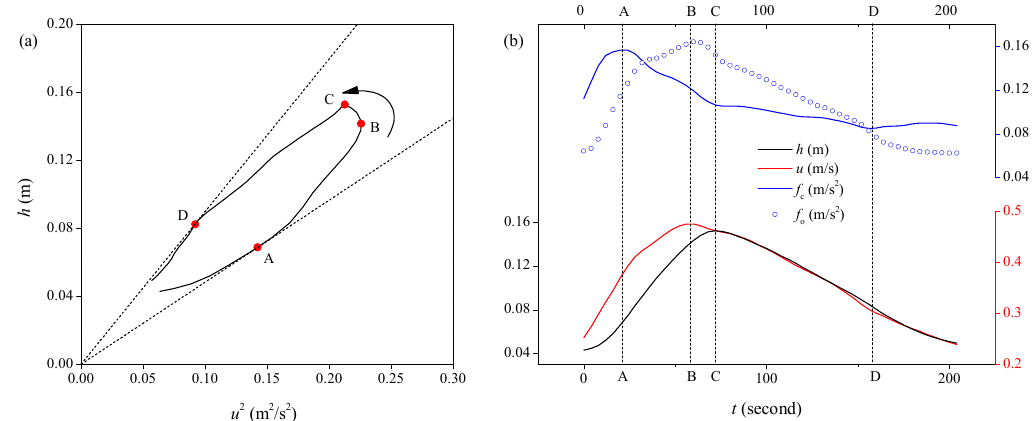
Figure 6. ( a ) Diagram of h and u 2 ( h – u 2 curve) where time points B and C indicate u and h peaks, and time points A and D indicate the peak and valley values calculated by term X1; ( b ) diagram of h , u , and f during the flood event (Mode 9, Exp. 2), where f o is the objective friction; f c is the calculated friction of term X1 with the same structure as the Chezy formula.